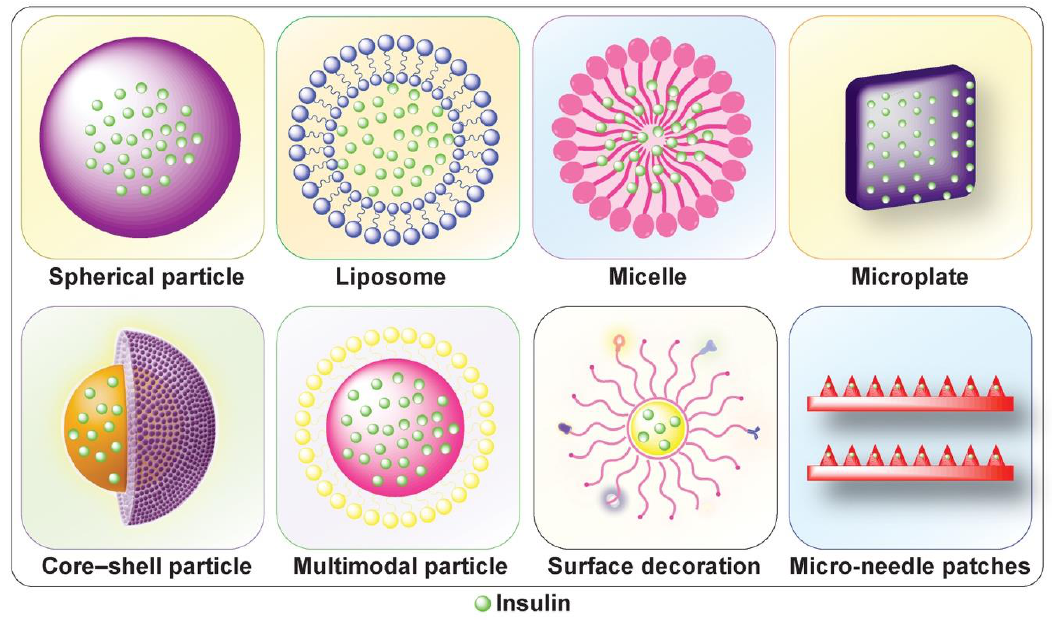
Figure 3. Schematic illustration of various types of macro- or nano-delivery platforms.